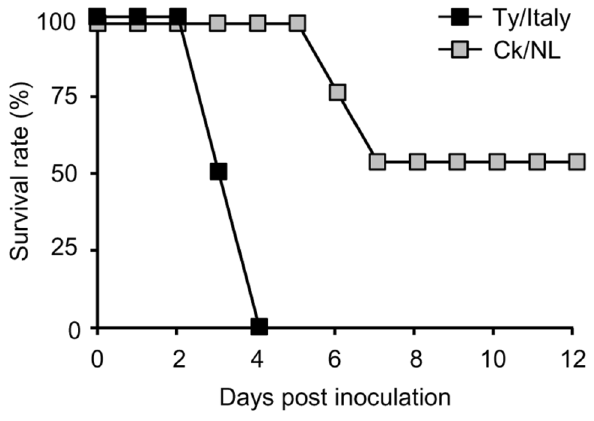
Figure 1. Survival rates of the chickens inoculated with Ty/Italy or Ck/NL. Chickens were intranasally inoculated with 10 6.0 EID of Ty/Italy or Ck/NL and were observed for 12 days. 50 doi: